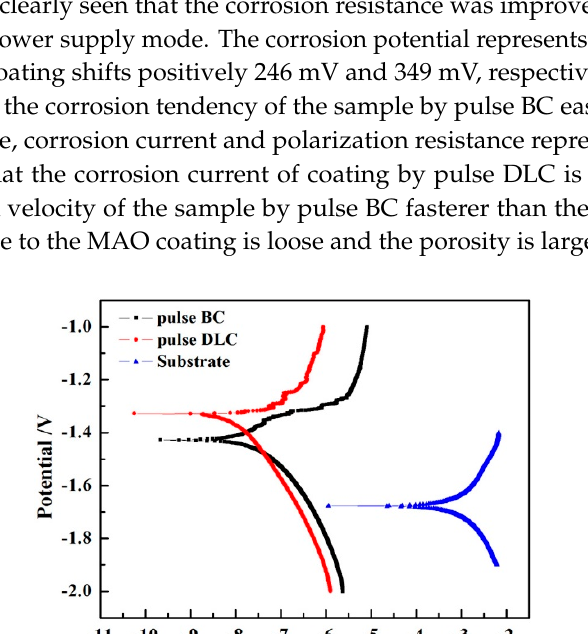
Figure 7. The growth rate of MAO coatings in power supply mode of pulse bipolar current and pulse with a discharge loop current.